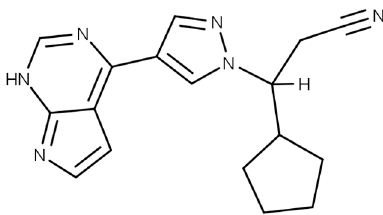
Figure 1. The chemical structure of ruxolitinib.